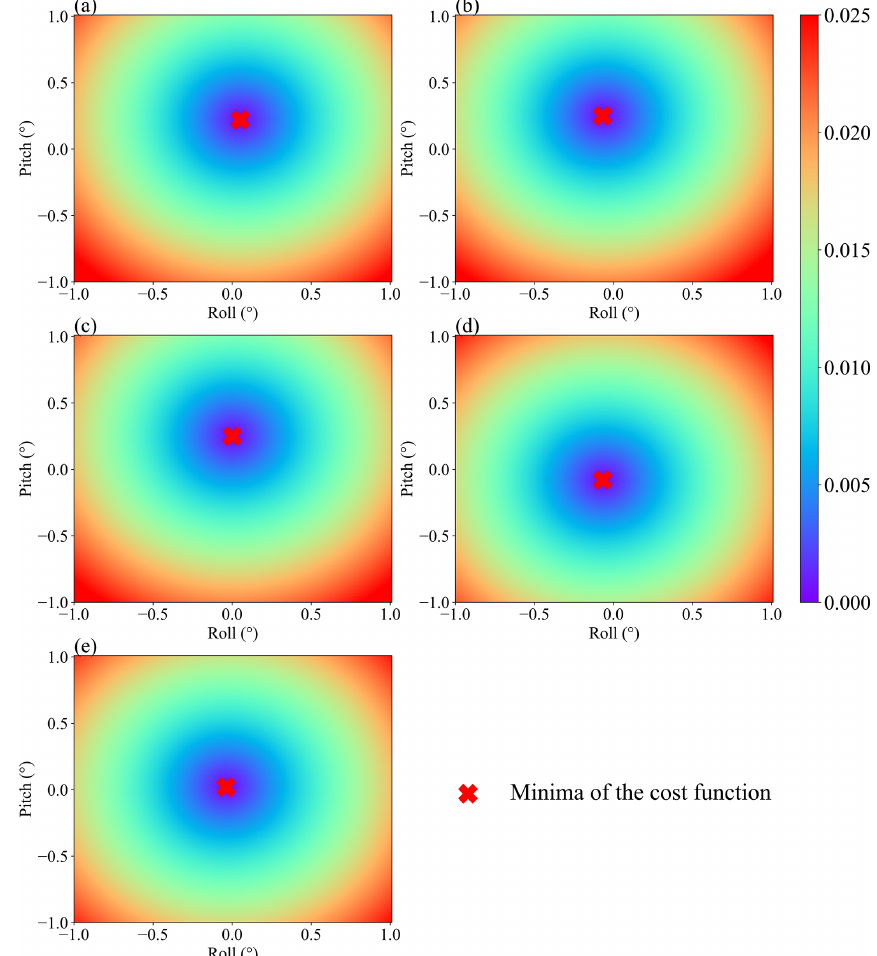
Figure 5. Variation in cost function with respect to the shifting of the Euler angle roll and pitch for ATMS channels 1 (a) , 2 (b) , 3 (c) , 16 (d) , and 17 (e) . The red crosses represent the points where the minima of the cost functions are found.